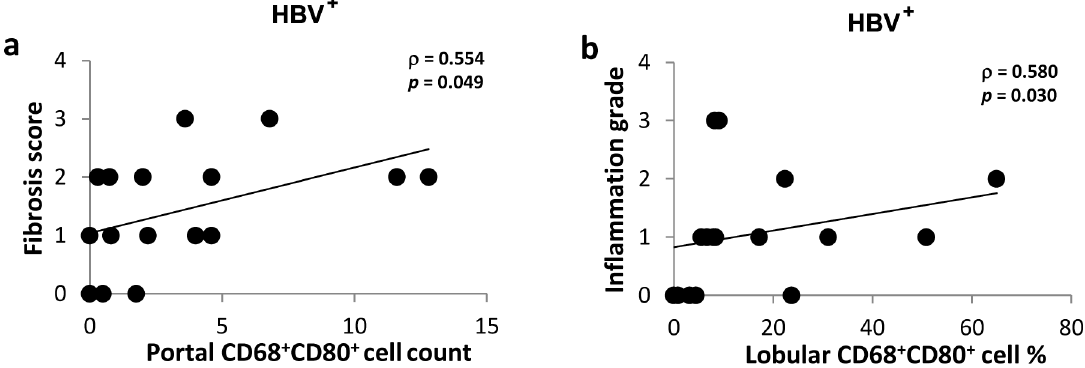
Fig 4. CD80 expression correlation with the fibrosis score and inflammation grade in HBV-infected liver. Biopsies from HBV-infected individuals were stained with mouse anti-human CD68 and rabbit anti-human CD80 Abs. Masson Trichrome stained slides were used to assess the fibrosis score and inflammation grade by Metavir scoring system. A. CD68 + CD80 + cell count in the portal and the fibrosis score. B. The percentage of CD68 + CD80 + cells in lobular areas and the lobular inflammation. * P value < 0.05. ** P value <